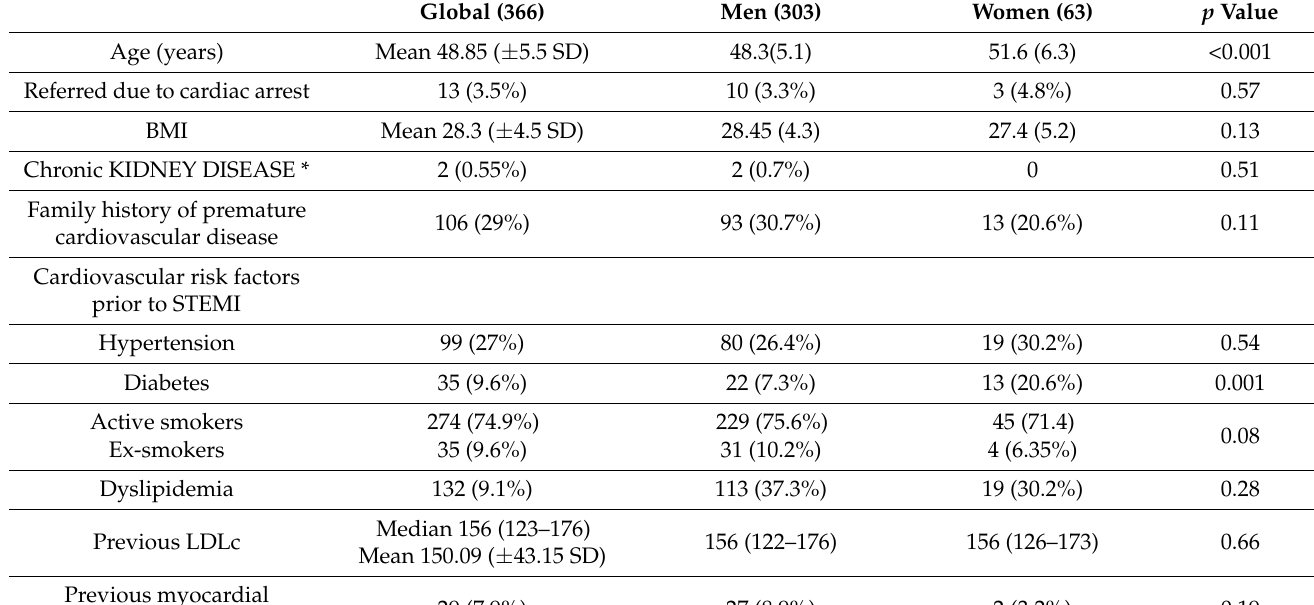
Table 1. Baseline characteristics of the premature STEMI